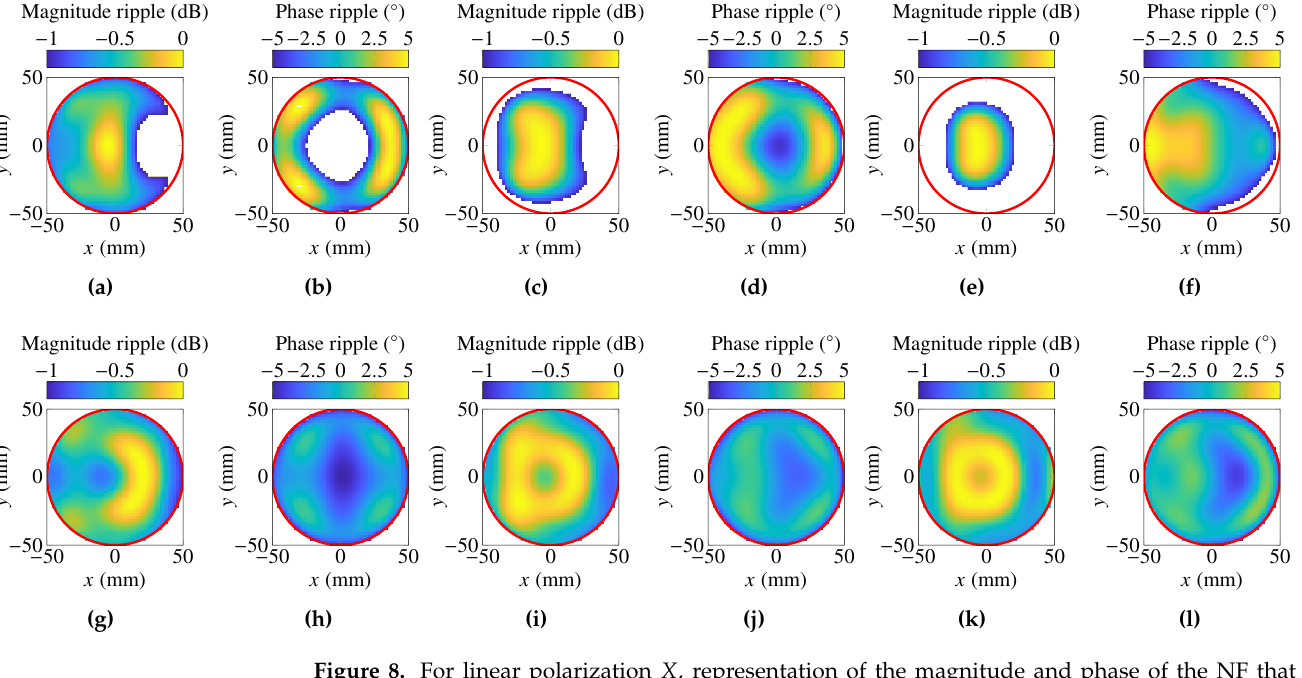
Figure 8. For linear polarization X , representation of the magnitude and phase of the NF that complies with a magnitude ripple of 1dB and phase ripple of 10° before ( top row) and after ( bottom row) the multi-frequency optimization. ( a ) Magnitude at 27GHz before optimization. ( b ) Phase at 27GHz before optimization. ( c ) Magnitude at 28GHz before optimization. ( d ) Phase at 28GHz before optimization. ( e ) Magnitude at 29GHz before optimization. ( f ) Phase at 29GHz before optimization. ( g ) Magnitude at 27GHz after optimization. ( h ) Phase at 27GHz after optimization. ( i ) Magnitude at 28GHz after optimization. ( j ) Phase at 28GHz after optimization. ( k ) Magnitude at 29GHz after optimization. ( l ) Phase at 29GHz after optimization. Similar results were obtained for polarization Y . Table 2 gathers the performance data of the optimized antenna. A compliance of 100% in region Ω 1 (see Figure 3) is achieved. Compared with the initial layout obtained after the POS, the worst magnitude ripple was reduced from 5.02 dB to 0.98 dB, while the worst phase ripple was reduced from 24.12° to